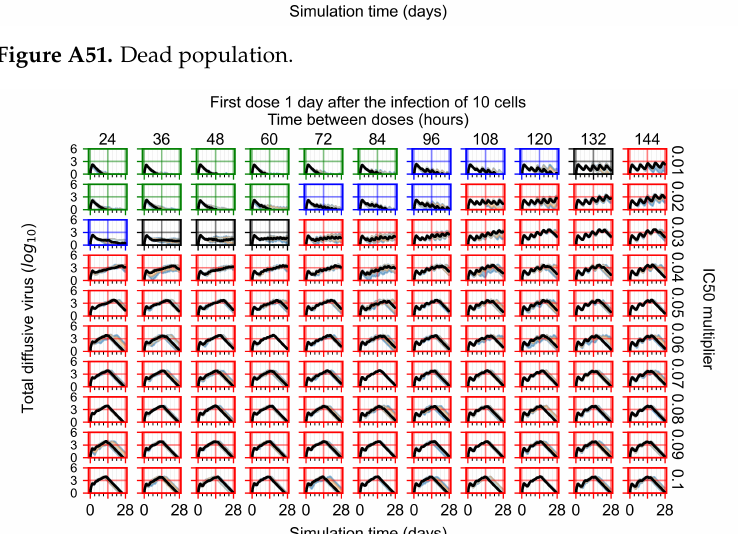
Figure A51. Dead population.